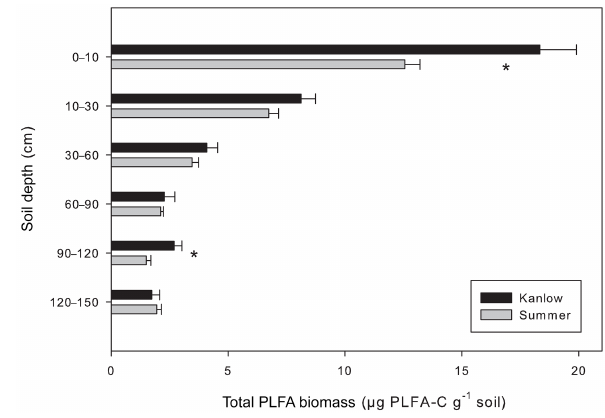
Figure 1. PLFA-derived C (µgPLFA-Cg − 1 soil) for switchgrass ecotypes Kanlow and Summer by depth. Error bars represent stan- dard deviations ( n = 3). The asterisk indicates a significance differ- ence between ecotypes within